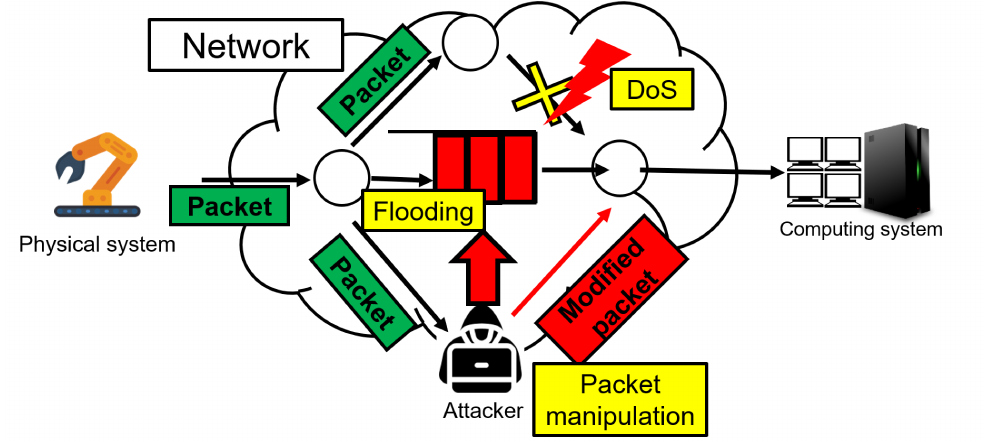
Figure 4. Cyber-physical attacks in the network